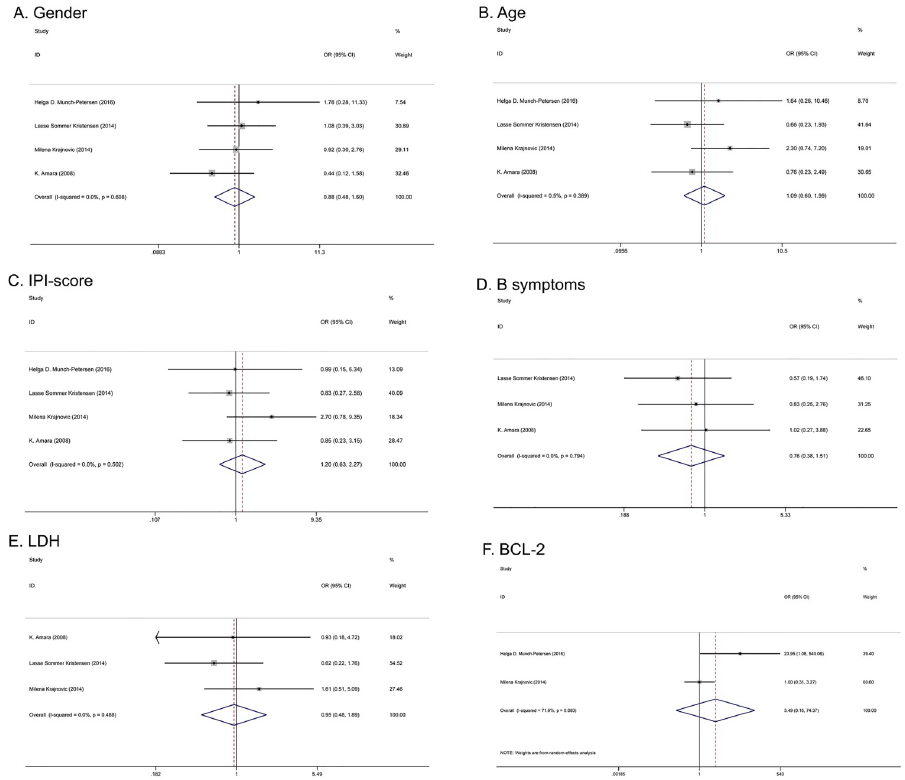
Fig 5. Association of DAPK methylation with clinical features of DLBCL. (A) Gender (B) Age (C) International prognostic factor (IPI) (D) B symptoms (E) Serum lactate dehydrogenase (LDH) (F) BCL-2 expressions.